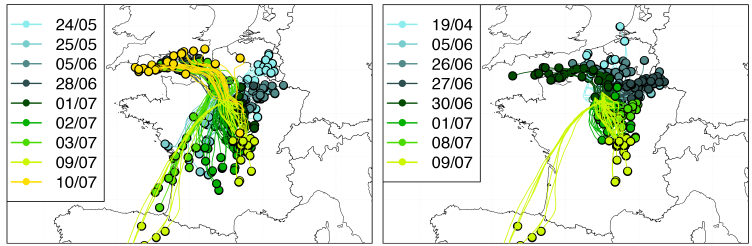
Figure 7. Back trajectories at D-1 (1 day before reaching Paris) associated with highest (a) NH 3 (left panel) and (b) HNO 3 (right panel) episodes (highest episodes being selected according to daily concentrations above the 97th percentile of all daily measurements, i.e., 9.2 and 0.9ppb for NH 3 and HNO 3 , respectively). For clarity, only back trajectories of seven particles around the center of Paris are plotted, each 6h (i.e., 28 back trajectories per